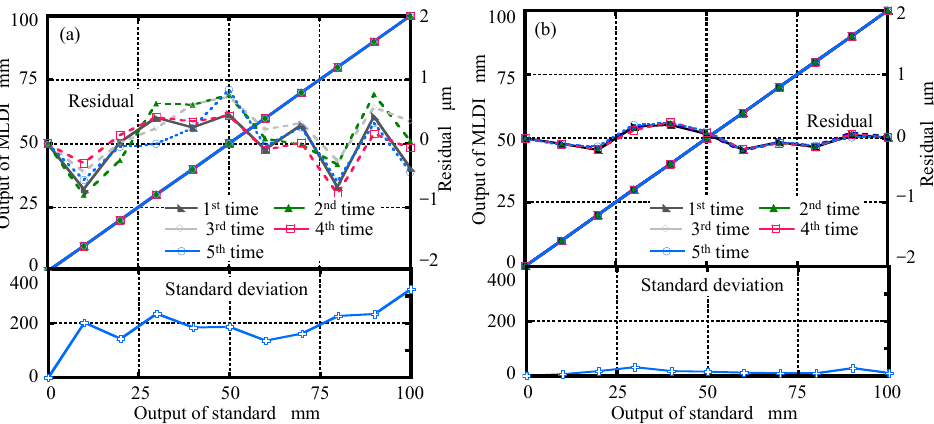
Figure 12. Displacement measurement results ( a ) without and ( b ) with the LD wavelength correction and stabilization.